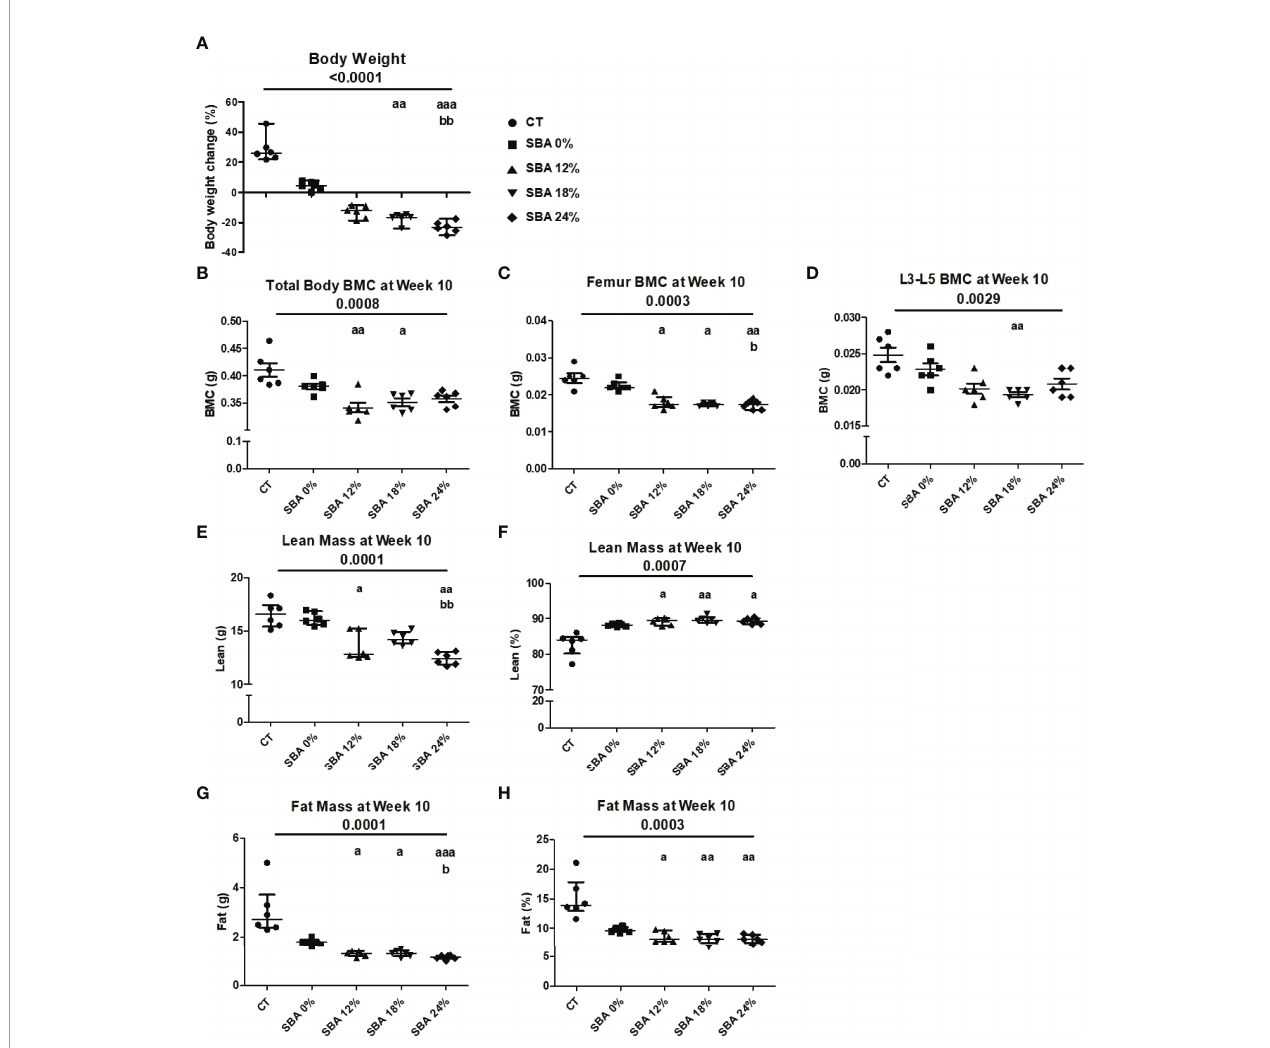
FIGURE 1 | Body mass, BMC, fat and lean mass in mice after 10 weeks of SBA protocols of different severity. The body weight and composition analysis were performed on standard condition (CT), constant weight group (SBA 0%) and three weight loss groups with different severity levels (SBA 12%, 18% and 24%). (A) Graph represents a percentage body weight loss on mice between day 0 and 10 weeks of SBA protocol; (B-D) Study of total mouse body mineral content (BMC), femur BMC and vertebra (L3-L5) BMC, respectively, were evaluated for each animal and each condition after 10 weeks of SBA protocol.; (E, F) Lean mass content presented in grams and % of total mass, respectively was evaluated for each mouse and condition after 4 weeks of SBA protocol; (G, H) Fat mass content presented in grams and % of total mass, respectively was evaluated for each mouse and condition after 4 weeks of SBA protocol. Data represent median and interquartile range; n = 6. Statistical analysis was performed using Kruskal-Wallis One-Way ANOVA test and Dunn ’ s test; a - p < 0.05, aa - p < 0.005 and aaa - p < 0.0005 when compared to the CT group (b – when compared to the SBA 0%